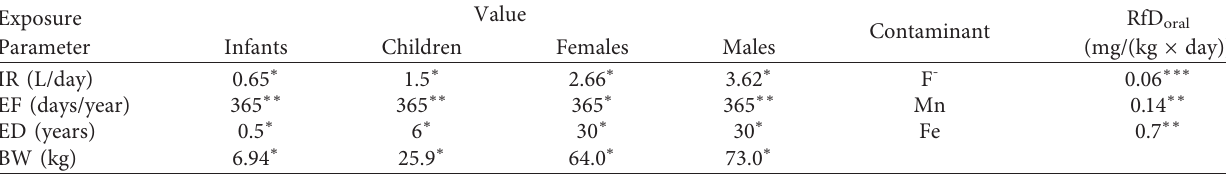
Table 1: The values of exposure parameters and RfD used in the HHAR model.